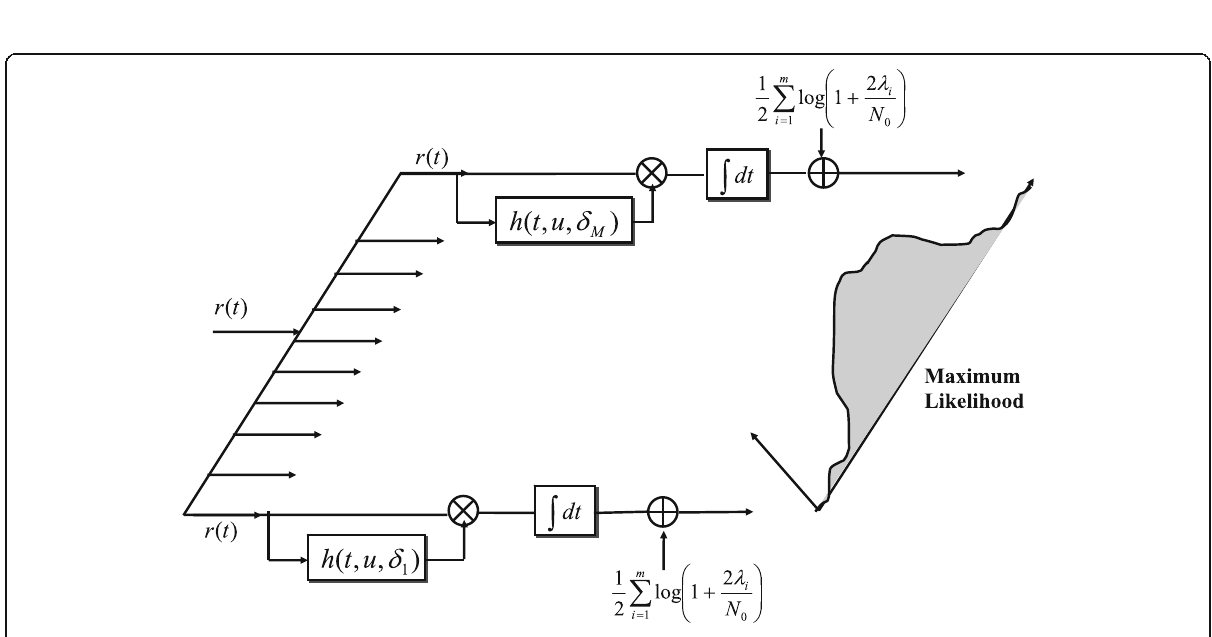
Fig. 3 Generation of maximum likelihood for TD